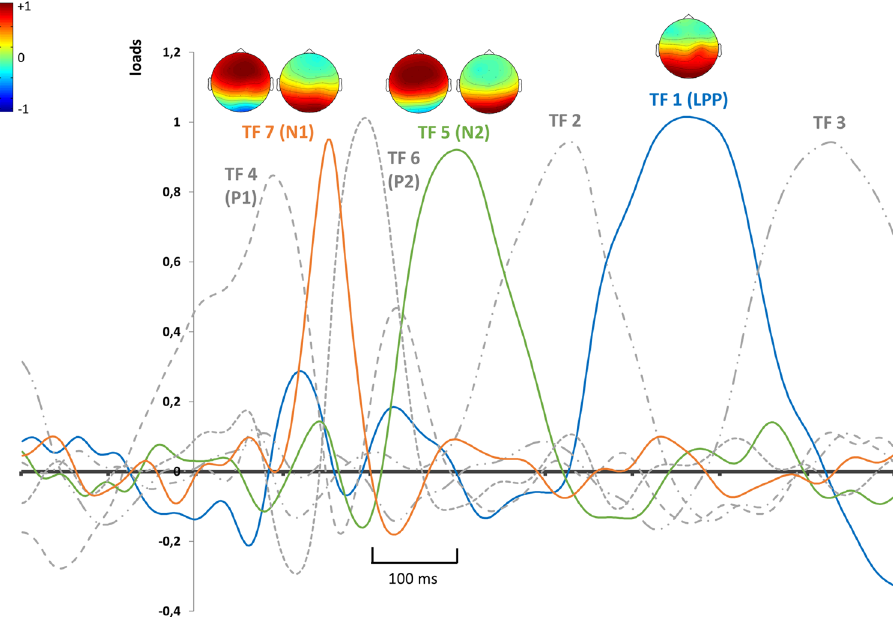
Figure 4. PCA factor loadings after promax rotation. Lines depict temporal loadings, and topographies represent spatial loadings. Temporal factors showing significant results are highlighted in